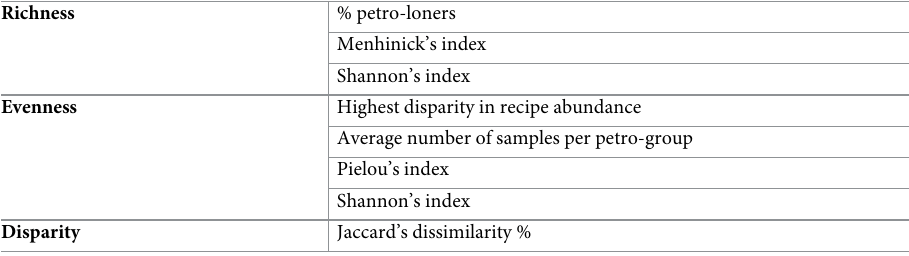
Table 4. Parameters considered for assessing the three different properties of diversity at a petrographic